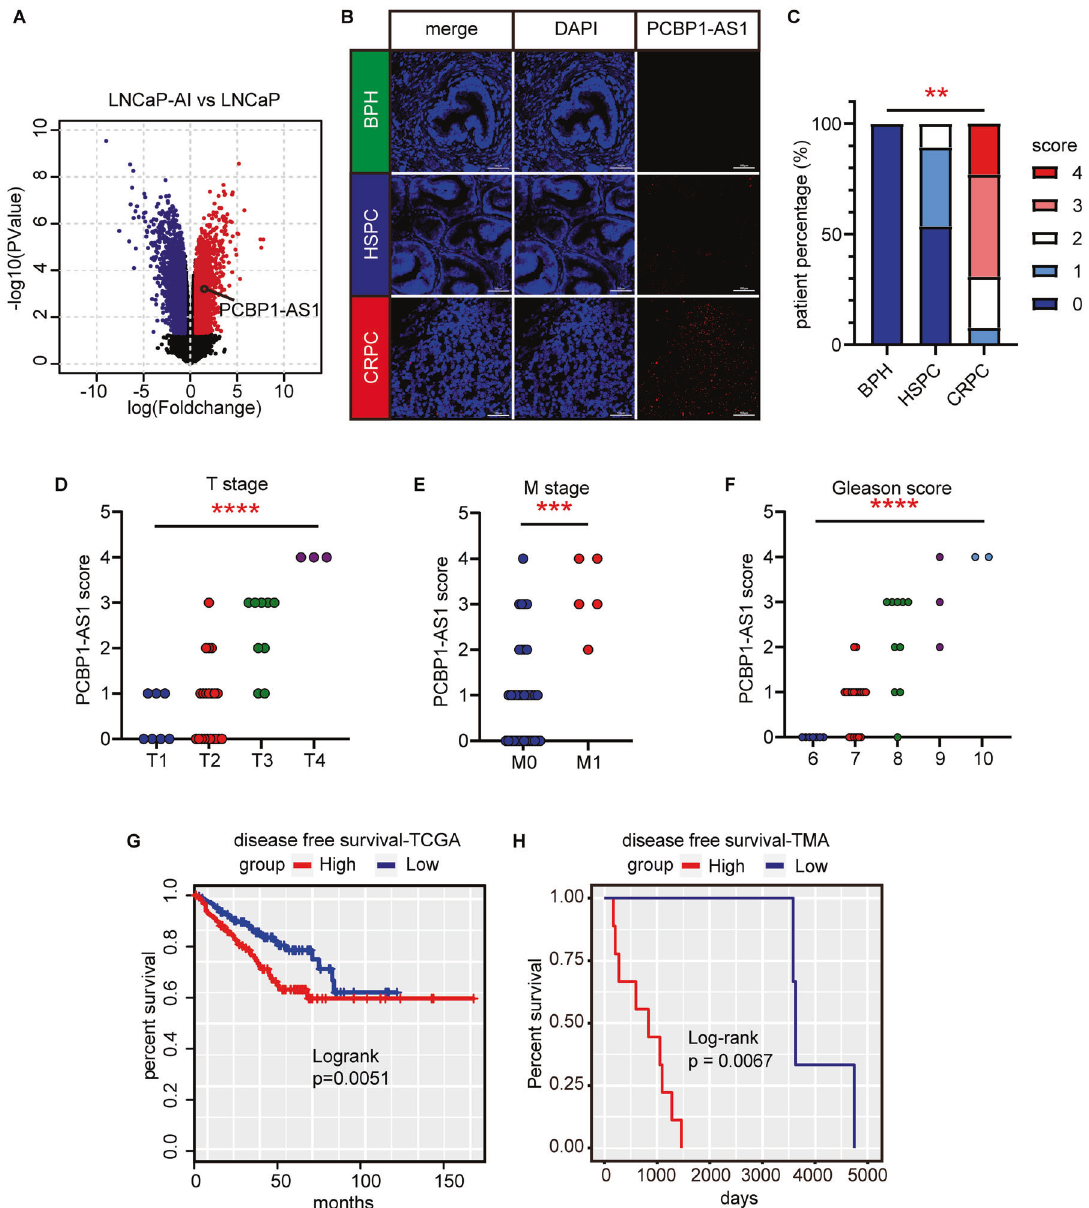
Fig. 1 Clinical investigation of PCBP1-AS1 in prostate cancer. A Volcano plot of gene expression fold change and P value in GSE124291 (LNCaP-AI versus LNCaP). Red dots refer to genes upregulated in LNCaP-AI, blue dots refer to genes upregulated in LNCaP. B RNA-Scope results using TMA. Red dots in the “ PCBP1-AS1 ” column refer to the expression of PCBP1-AS1 in indicated patient tissue. C Summary of the score in RNA-scope. The scoring is carried out in accordance with ACD ’ s corresponding speci fi cation standards. D – F The comparison results of T stage, M stage, and Gleason score of patients in TMA. ANOVA is used to calculate P value. G , H Kaplan – Meier survival plot of patients in TCGA database and TMA. Groups are divided by the median expression or RNA-scope score of PCBP1-AS1. Signi fi cance: * P <0.05, ** P <0.01, *** P <0.001, **** P